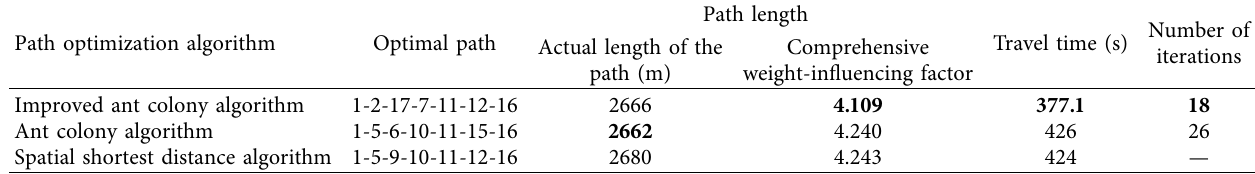
Table 9: Comparison of various algorithms in Instance